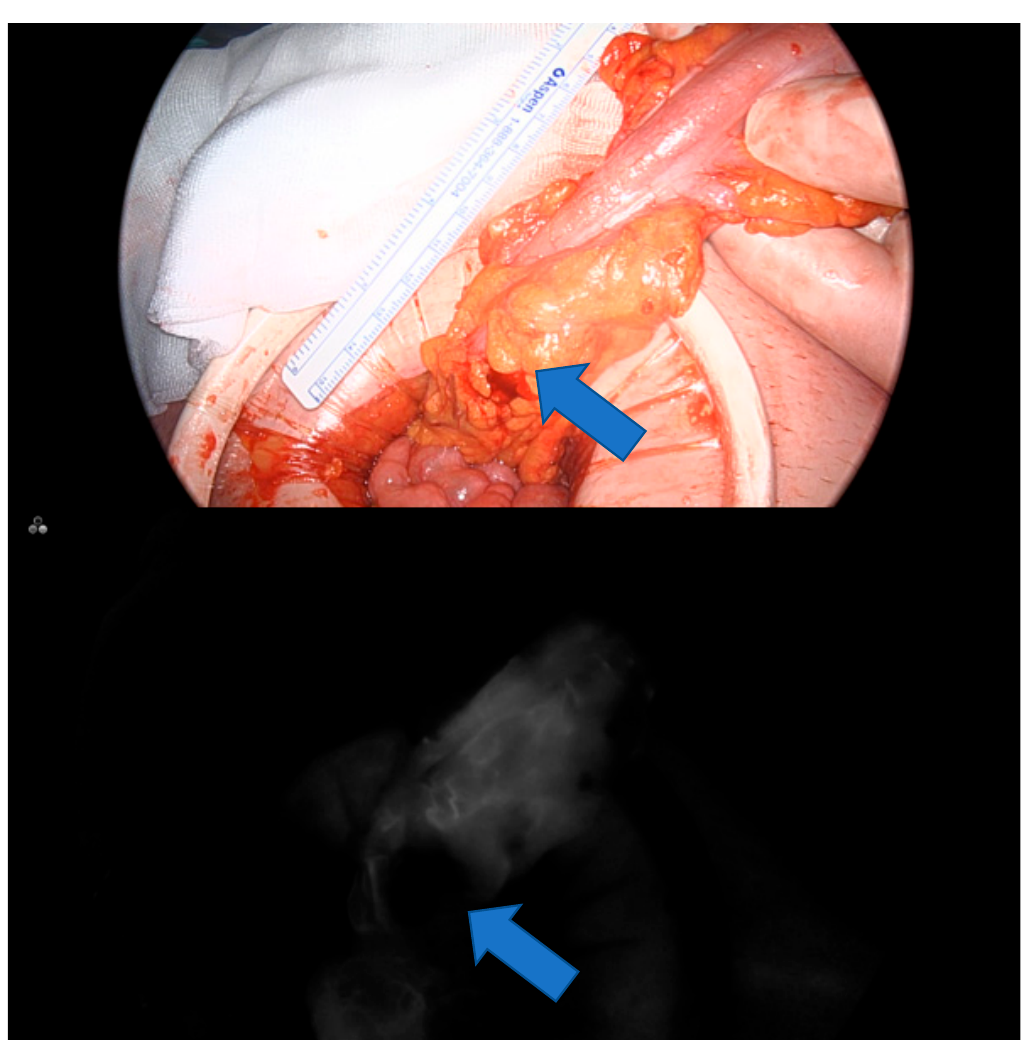
Figure 1. A segment of colon during a transanal total mesorectal excision. The top image is the white light image and the image below, the corresponding fluorescent image, demonstrating less fluorescent enhancement at a more proximal bowel segment (see blue arrow).